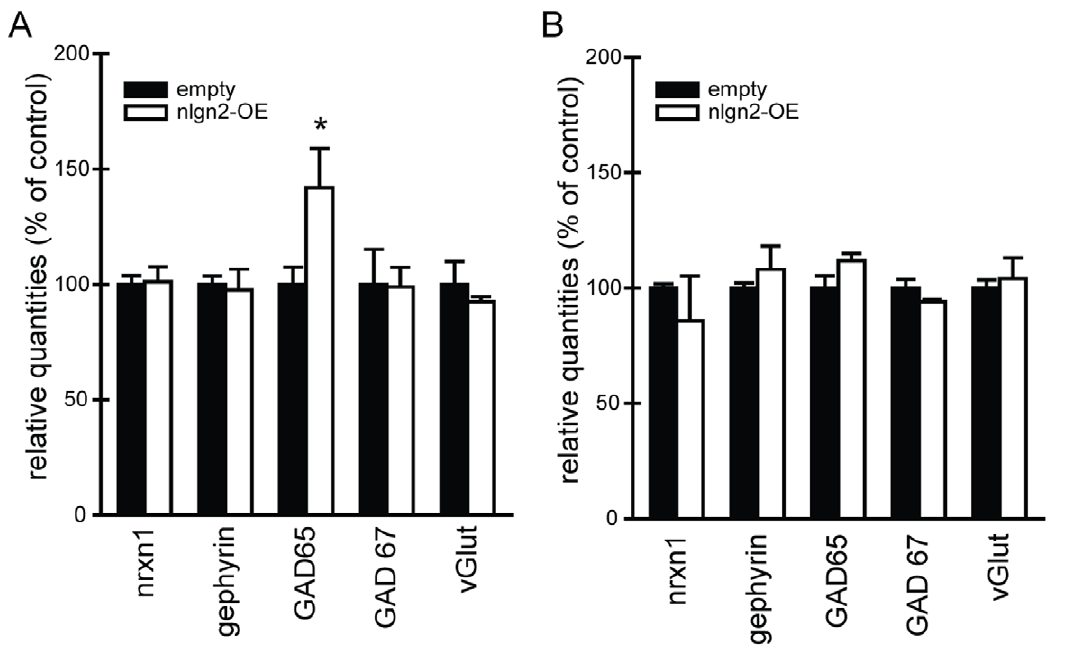
Figure 5. mRNA expression. A, mRNA expression in the dorsal hippocampus. Nrxn1: T (9) = 2 0.155, p . 0.05; Gephyrin: T (9) =0.279, p . 0.05; GAD65: T (9) = 2 2.404, p , 0.05*; GAD67: T (9) =0.059, p . 0.05; vGlut: T (5.439) =0.739, p . 0.05. B, mRNA expression in the ventral hippocampus. Nrxn1: T (4.071) =0.732, p . 0.05; Gephyrin: T (9) = 2 0.850, p . 0.05; GAD65: T (9) =0.380, p . 0.05; GAD67: T (9) =1.392, p . 0.05; vGlut: T (9) = 2 0.457, p . 0.05. Empty n=6, nlgn2-OE n=5. *significantly different from empty animals.